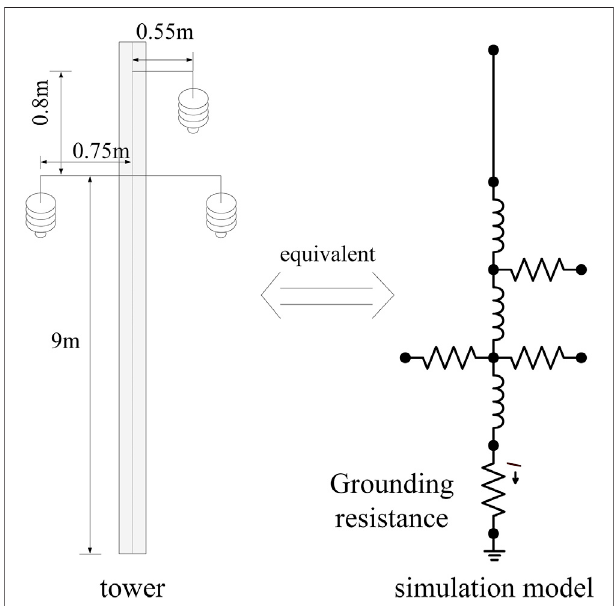
FIGURE4| Towerof10,5 kVtransmissionlineanditssimulationmodel.